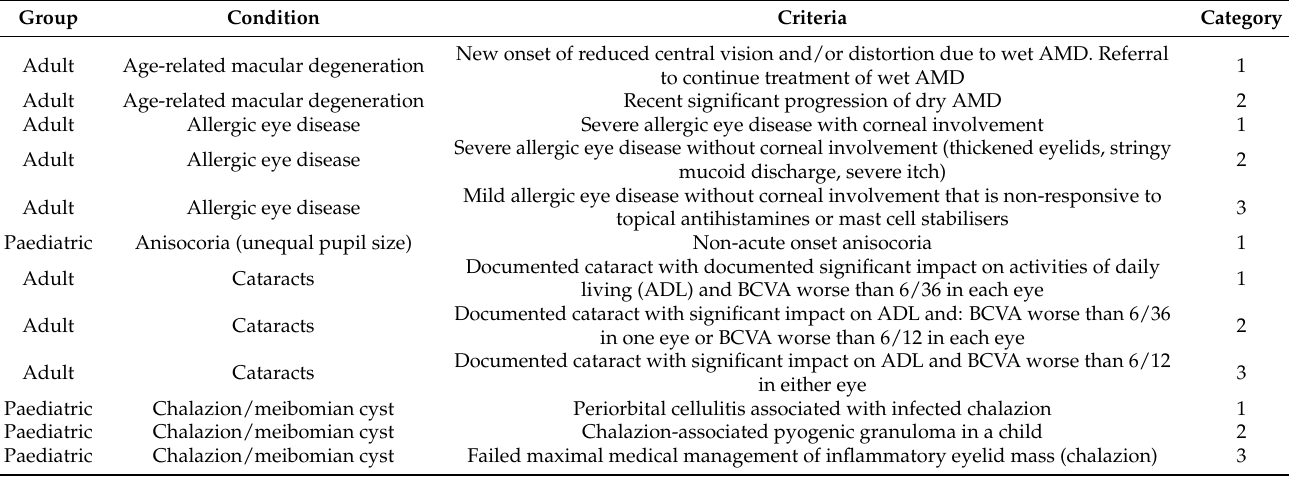
Table 1. A section of CPC on ophthalmology speciality and conditions